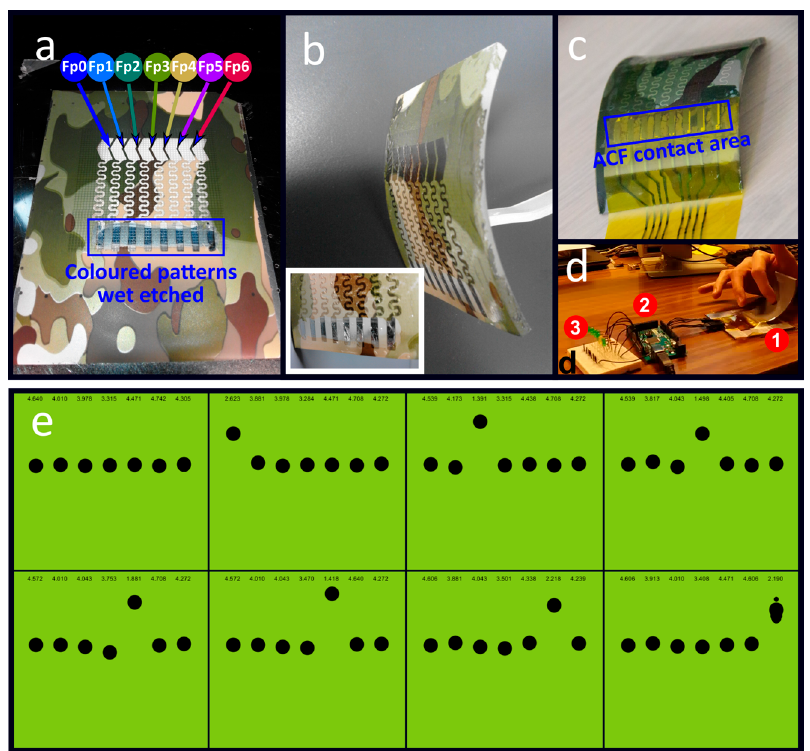
Figure 4. Discrete and hidden electronics applications. Optical picture of capacitive sensors transferred to bent plastic object; ( a ) top-view of metallic electrodes fabricated on colorized PVA substrate. Electrodes constitute the devices sensing area. In blue, the area where part of the colored films has been etched for electrical interconnections access; ( b ) electrodes transferred onto a white object (discrete electronics). The inset highlights a zoom on the area where interconnects can be performed; ( c ) electrodes transferred onto a darker object (hidden electronics) showing electrodes interconnected with the kapton cable using anisotropic conductive film enabling external measurements; ( d ) electrical test setup. The marks 1, 2, and 3 highlight the backside of the capacitive sensors, the Arduino board, and LEDs to display finger displacement, respectively; ( e ) animated graphics showing finger movement tracking using the Arduino board and the Processing software (version 3.4).